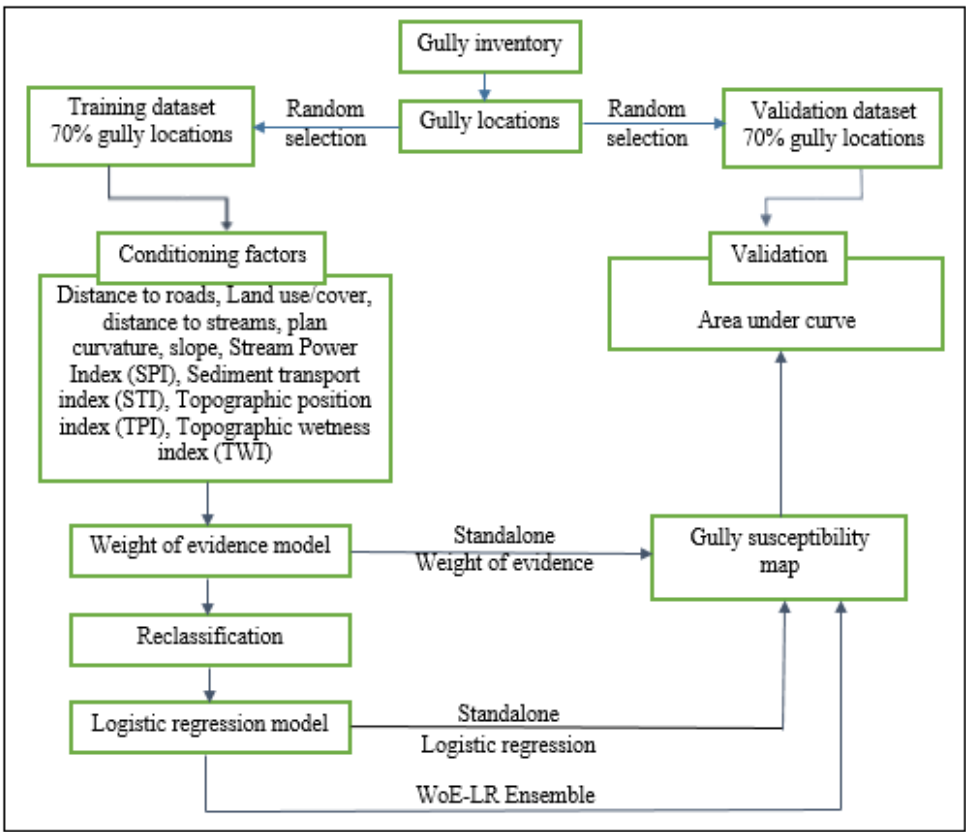
Figure 2. Flowchart for the research methodology on gully erosion susceptibility mapping in Kakia- Esamburmbur catchment, Narok.